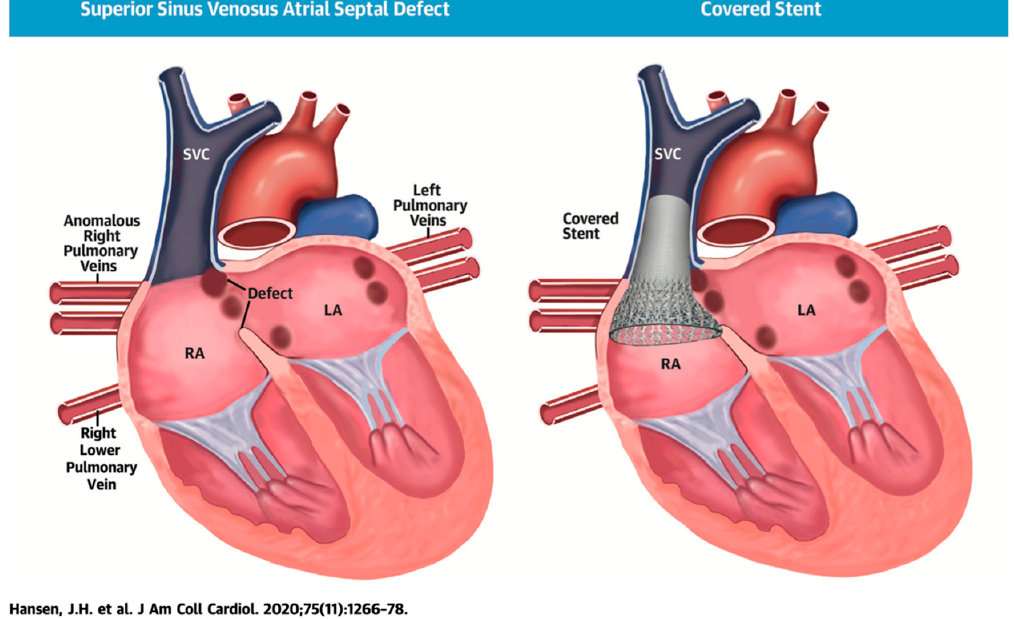
Figure 1. Illustration of successful covered stent placement with closure of the SVASD. The anomalous pulmonary veins now drain directly to the left atrium (LA) while the SVC drains entirely to the RA. Revised from ref [4].